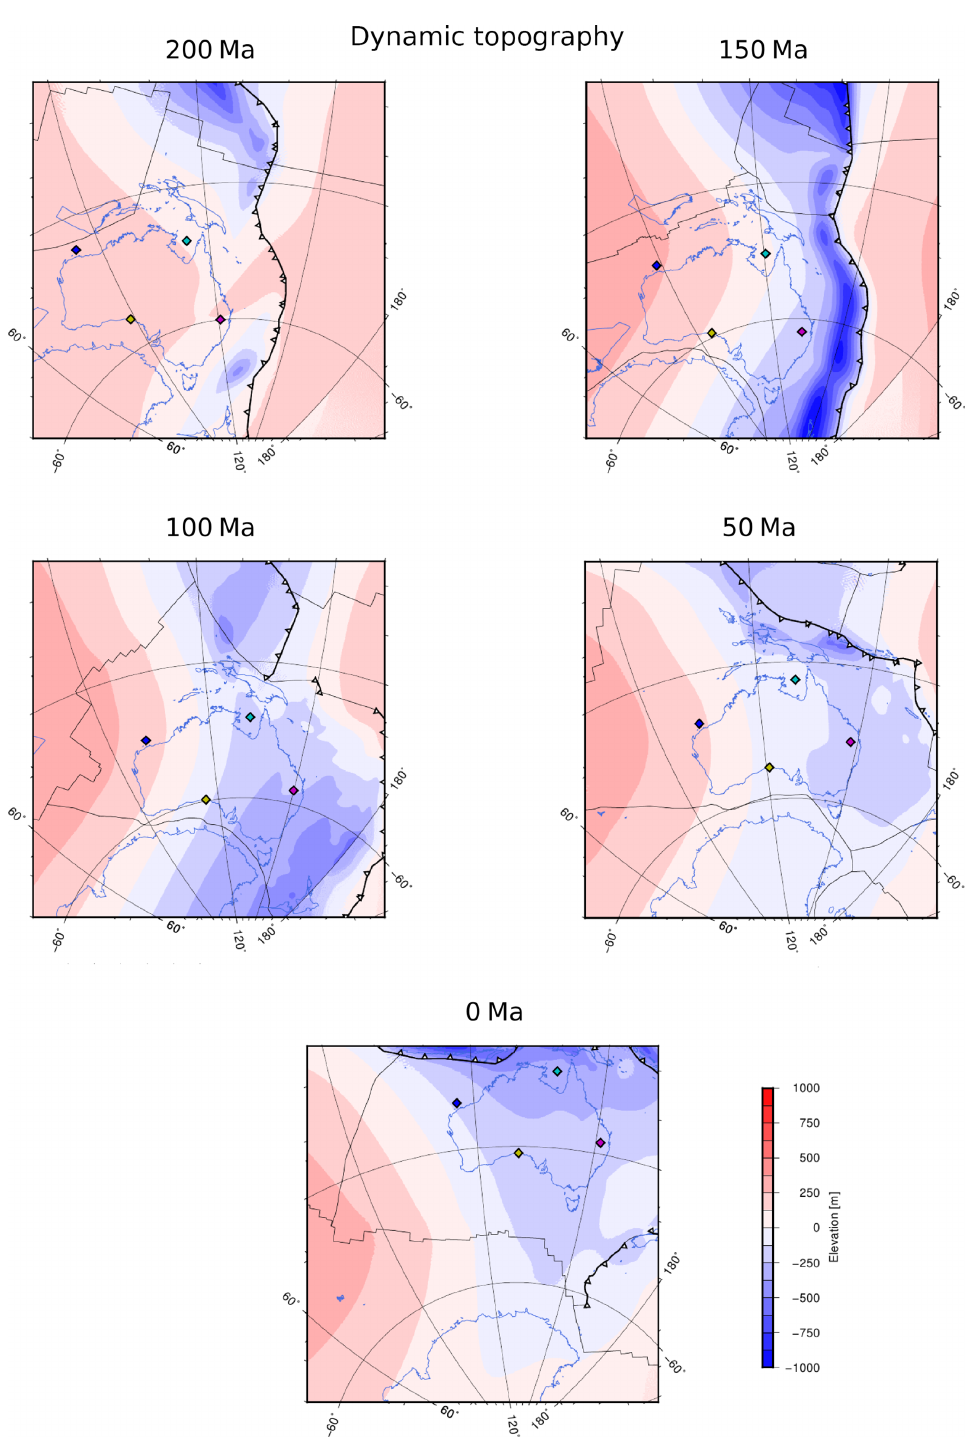
Figure 6. Dynamic topography evolution for Australia, analogous to Fig. 4a. Between 200 and 120Ma, Australia’s eastern margin experiences westward-directed subduction of the Phoenix plate. From 50Ma onward Australia’s dynamic topography is dominated by the northward-directed subduction of the Australian plate under the Indonesian archipelago. See the Supplement for dynamic topography evolution in 10Myr time